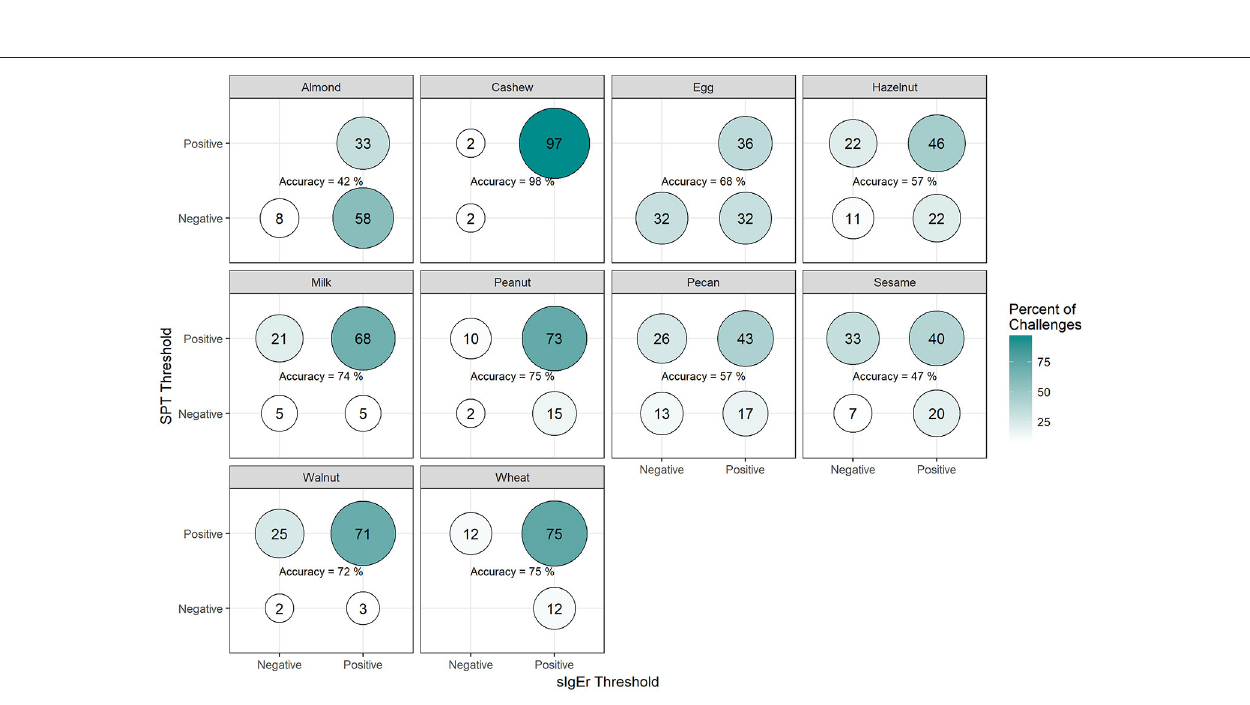
Frontiers in Immunology | www.frontiersin.org